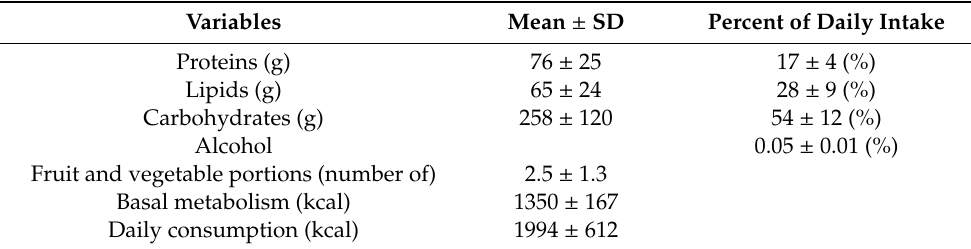
Table 1. Mean nutrients and energy intake of the cohort at